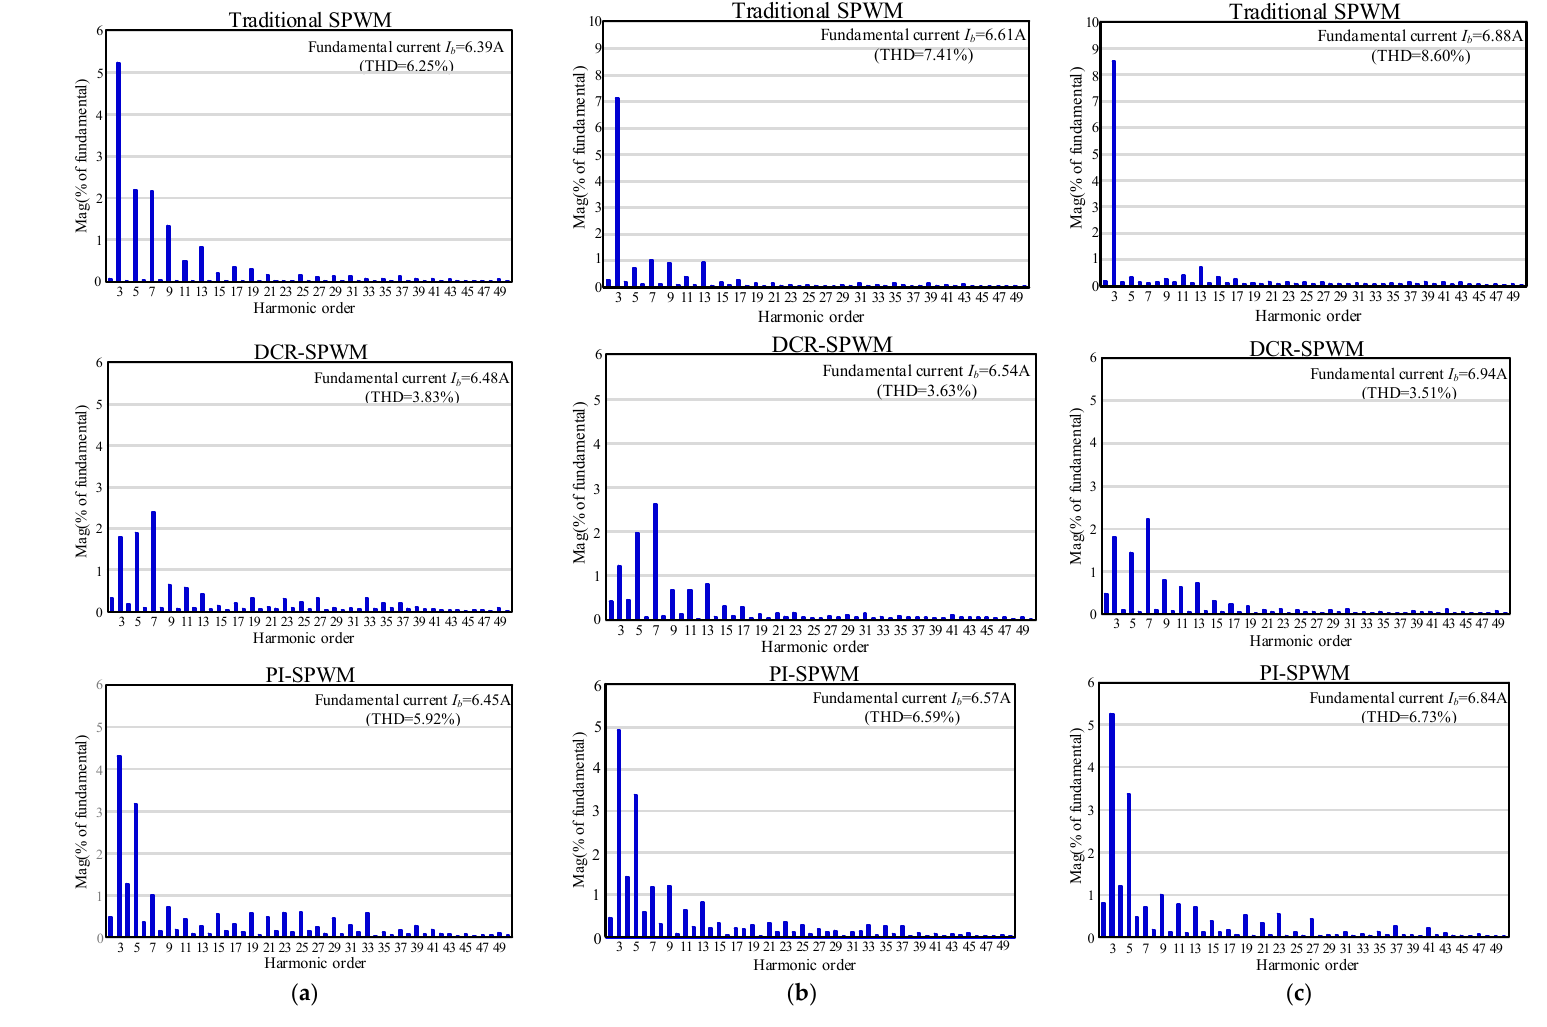
Figure 14. Harmonics distribution of i b : ( a ) λ = 0.1; ( b ) λ = 0.15; ( c ) λ = 0.2.